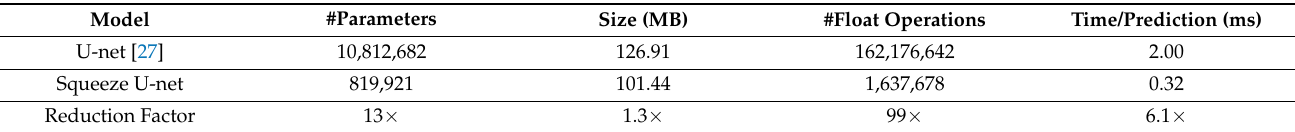
Table 6. Quantitative comparison between U-net and Squeeze U-net regarding model size, number of operations, and prediction